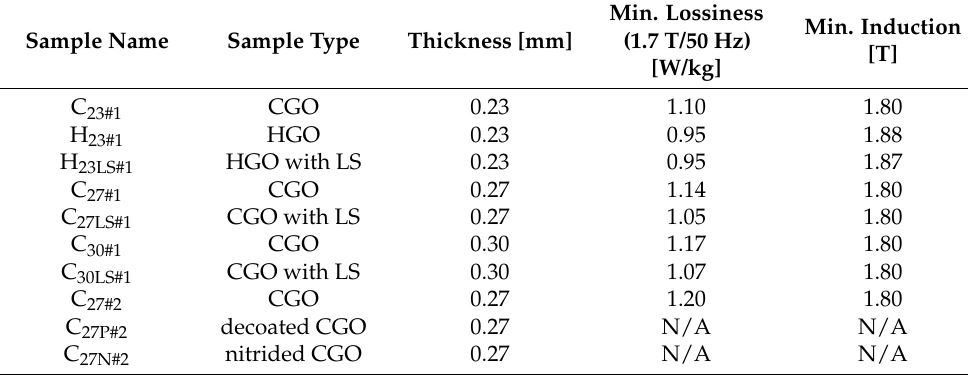
Table 1. The steel samples set with their